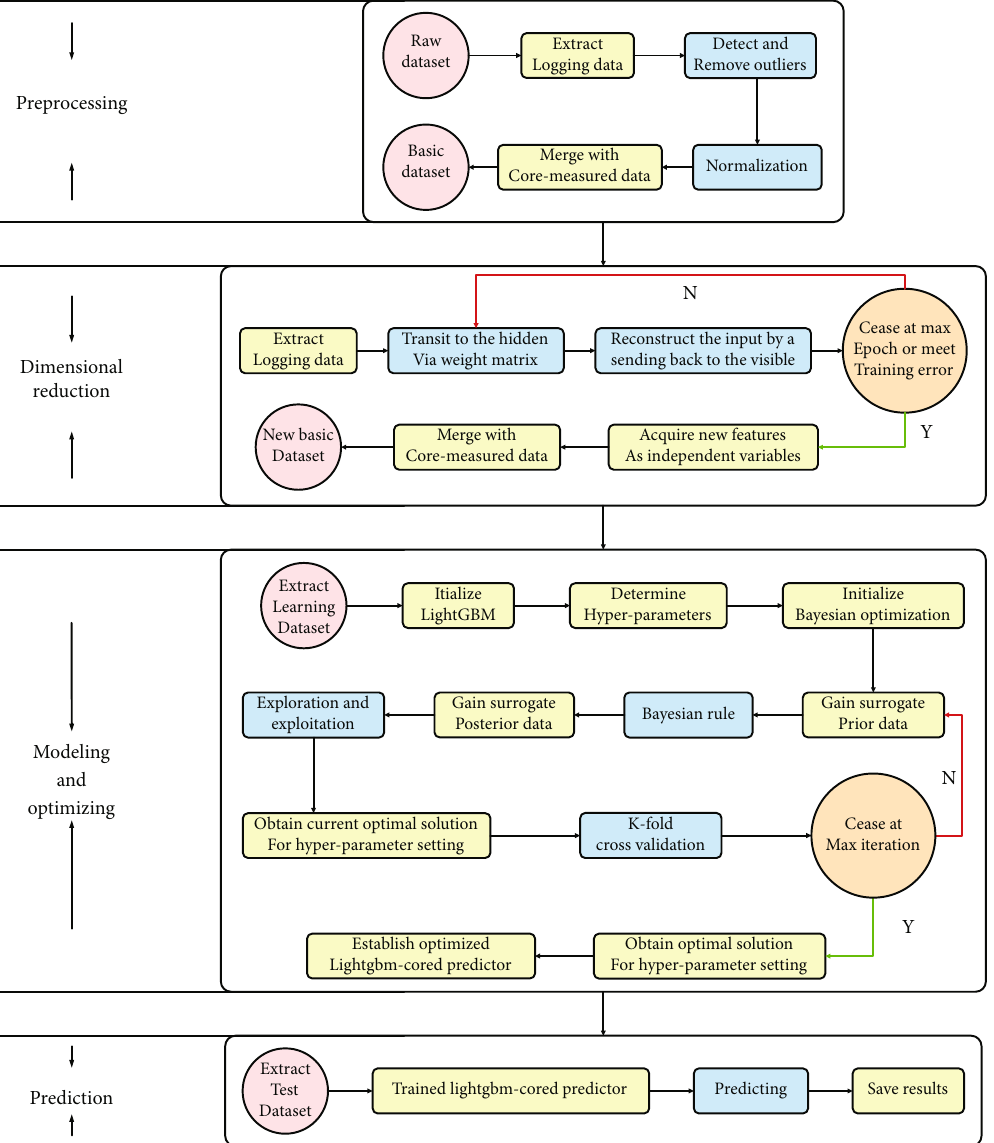
Figure 1: Computing fl ow of LightGBM-cored predictor for petrophysical regression of sandy-mud reservoirs. LightGBM =light gradient boosting